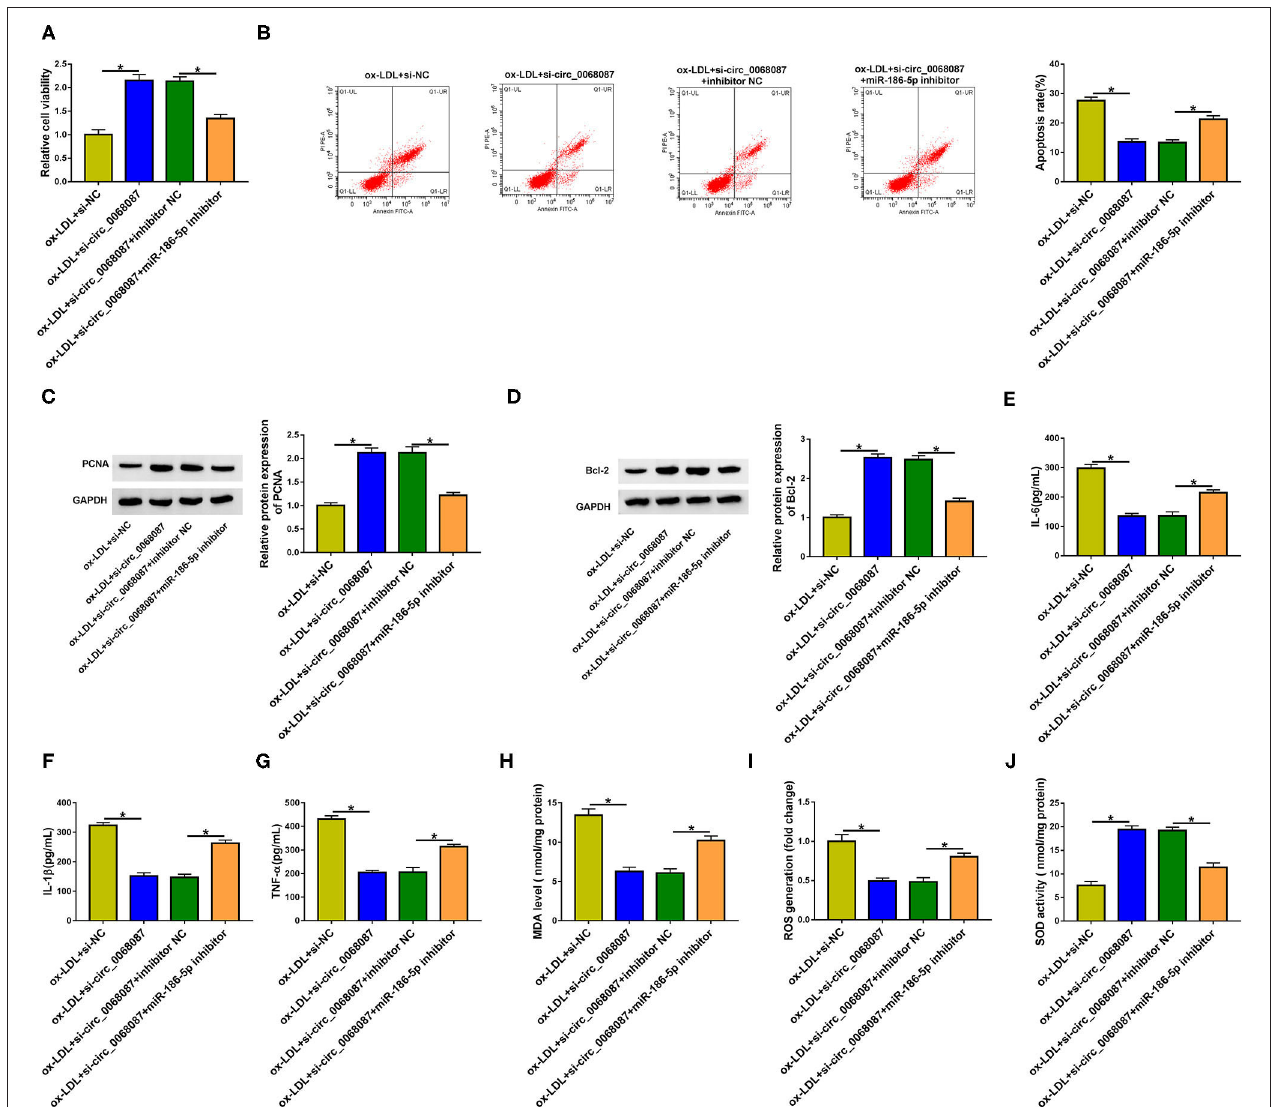
FIGURE 4 | Circ_0068087 silencing attenuates ox-LDL-induced damage in HUVECs partly by upregulating miR-186-5p. (A–J) HUVECs were transfected with si-circ_0068087 alone or together with miR-186-5p inhibitor prior to ox-LDL exposure (40 mg/L; 24h). One-way ANOVA followed by Tukey’s post hoc test was used to assess the differences. (A) MTT assay was performed to analyze cell viability. This experiment was performed three times with five technical repetitions each time. (B) Cell apoptosis rate was assessed through performing flow cytometry. This experiment was performed three times with three technical repetitions each time. (C,D) The levels of proliferation marker (PCNA) and apoptosis marker (Bcl-2) were measured by Western blot assay. This experiment was performed three times. (E–G) Cell inflammatory response was evaluated by ELISA. This experiment was performed three times with three technical repetitions each time. (H–J) The levels of MDA and ROS and the activity of SOD were determined by their commercial kits. This experiment was performed three times with three technical repetitions each time. * P <